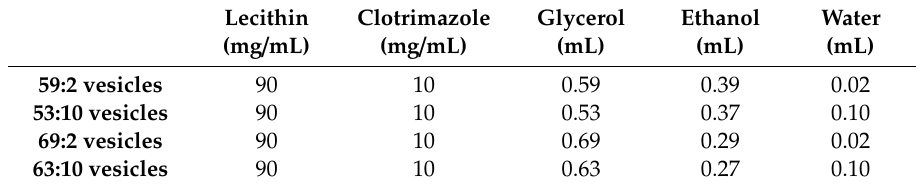
Table 1. Composition of clotrimazole loaded three-dimensionally-structured hybrid vesicles. Lecithin Clotrimazole Glycerol (mg / mL) (mg / mL) (mL)